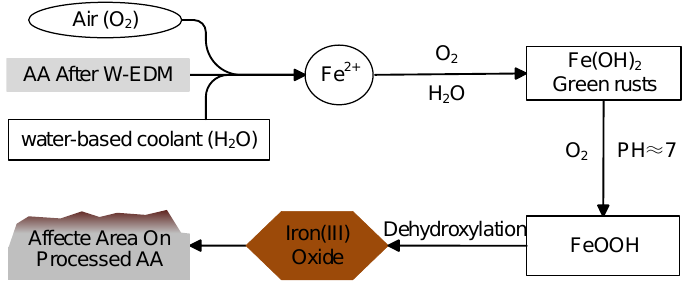
Figure 15. Schematic diagram of the